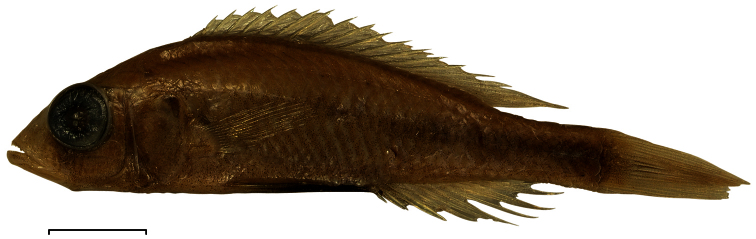
Preserved colours of Haplochromis goldschmidti sp. n. ♂ 60.3 mm SL (holotype, RMNH.PISC.83573). Scale bar equals 10 mm.